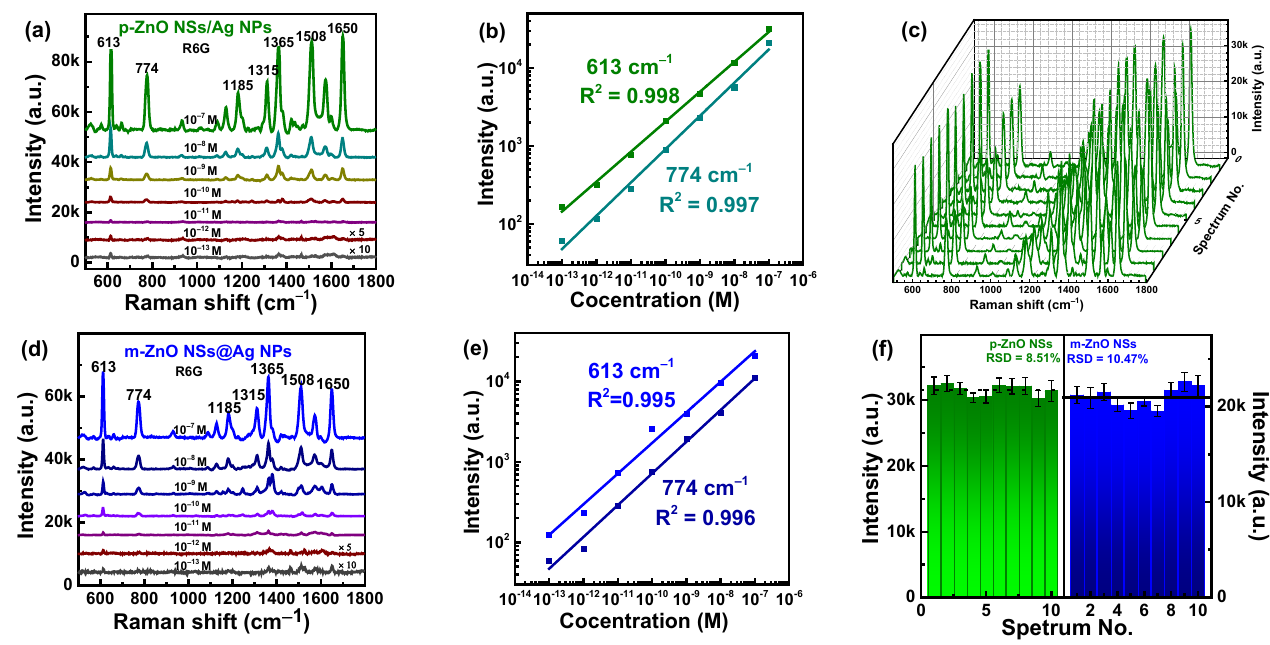
Figure 5. Raman spectra of R6G with different concentrations on the Si/p-ZnO NSs/Ag NPs ( a ) and Si/m-ZnO NSs/Ag NPs ( d ) substrates. Calibration curve of Raman intensity at 613 cm − 1 versus the concentration of R6G ( b ) and ( e ). Ten Raman spectra of R6G with a concentration of 10 − 7 M on the Si/p-ZnO NSs/Ag NPs substrate from different batches ( c ). Intensities distribution of 613 cm − 1 peaks of the ten Raman spectra for the Si/p-ZnO NSs/Ag NPs or Si/m-ZnO NSs/Ag NPs substrates ( f ).